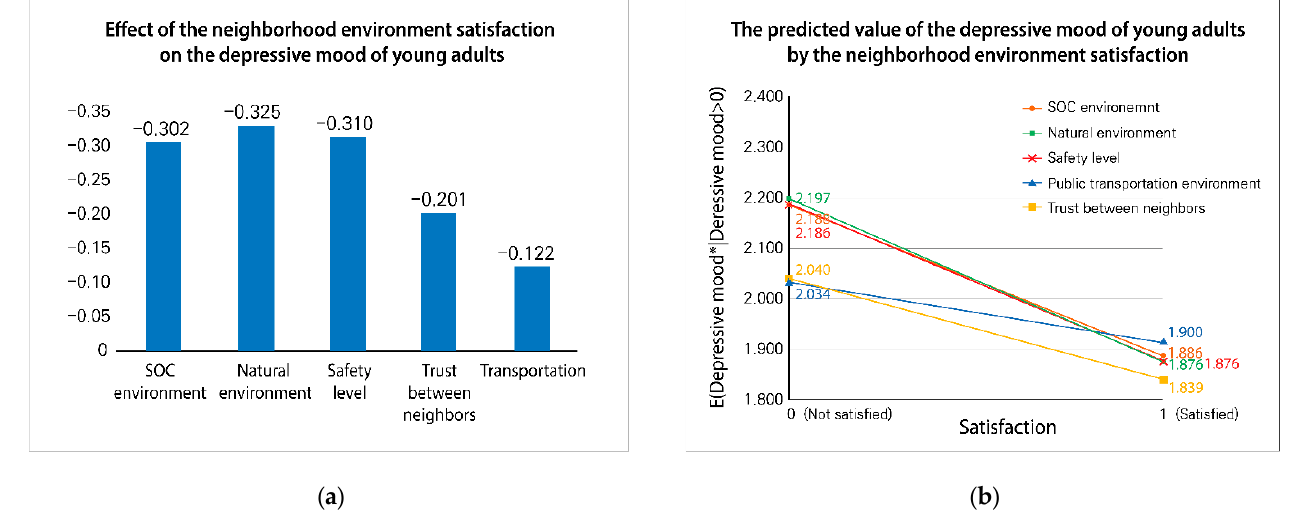
Figure 1. ( a ) Effects of neighborhood environment satisfaction on depressive mood; ( b ) The predictive value of the depressive mood of young adults by the neighborhood environment satisfaction.